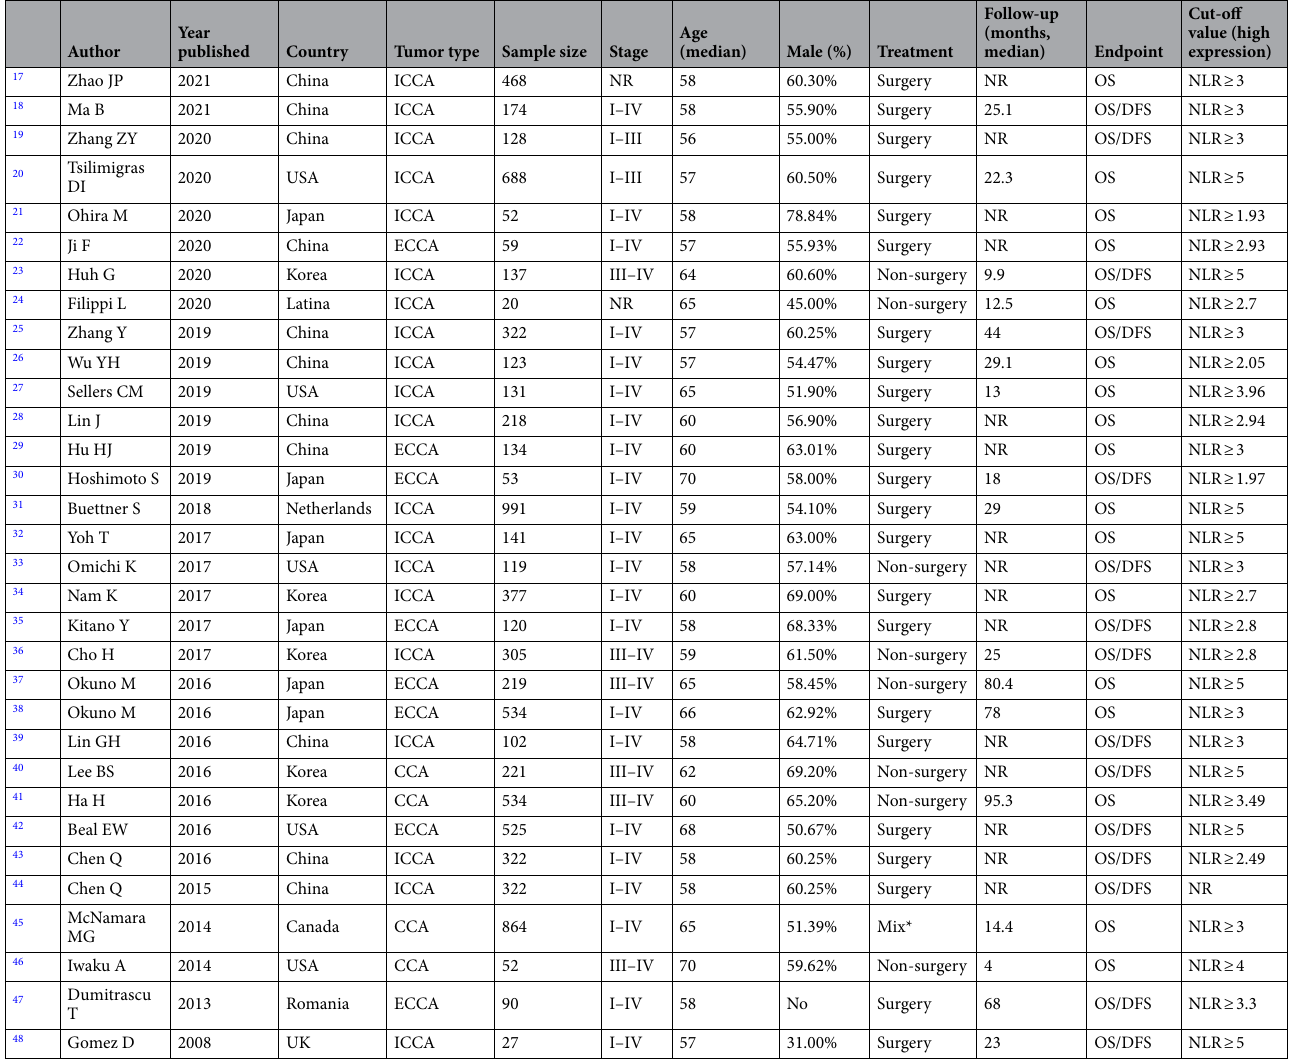
Table 1. Characteristics of included studies. Mix*, including 326 surgical and 538 non-surgery cases, CCA cholangiocarcinoma, DFS disease-free surviva, ECCA extrahepatic cholangiocarcinoma, ICCA